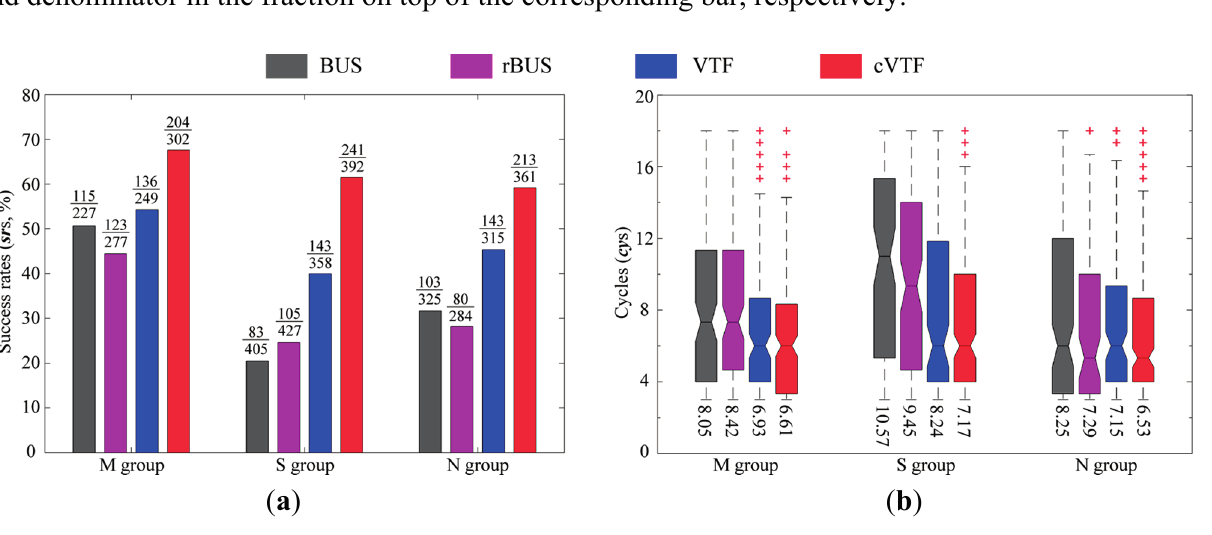
Figure 12. Numerical results. ( a ) Success rates in the three groups of experiments. The numerator and denominator of the fraction on each bar are the corresponding number of successful Track-Out activities and total number of Track-Out activities, respectively; ( b ) Box plots with the whisker lengths specified as 1.0 times the interquartile range for each method in the three